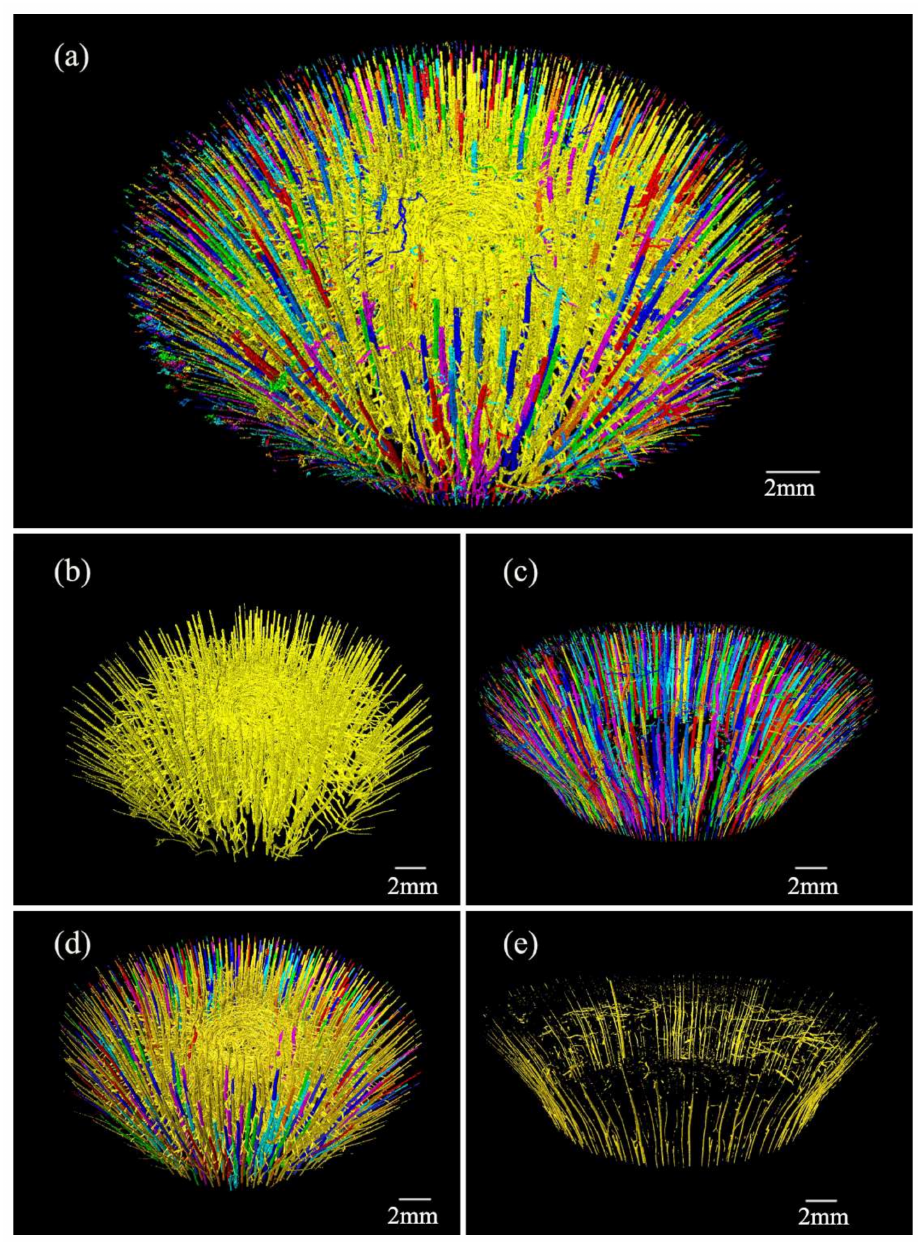
Figure 9. Conducting tissue in the diaphragm. ( a ) Three-dimensional model of the conducting tissue. ( b ) Conducting tissue with the largest volume. ( c ) Area except the conducting tissue with the largest volume. ( d ) Connected conducting tissue. ( e ) Unconnected conducting